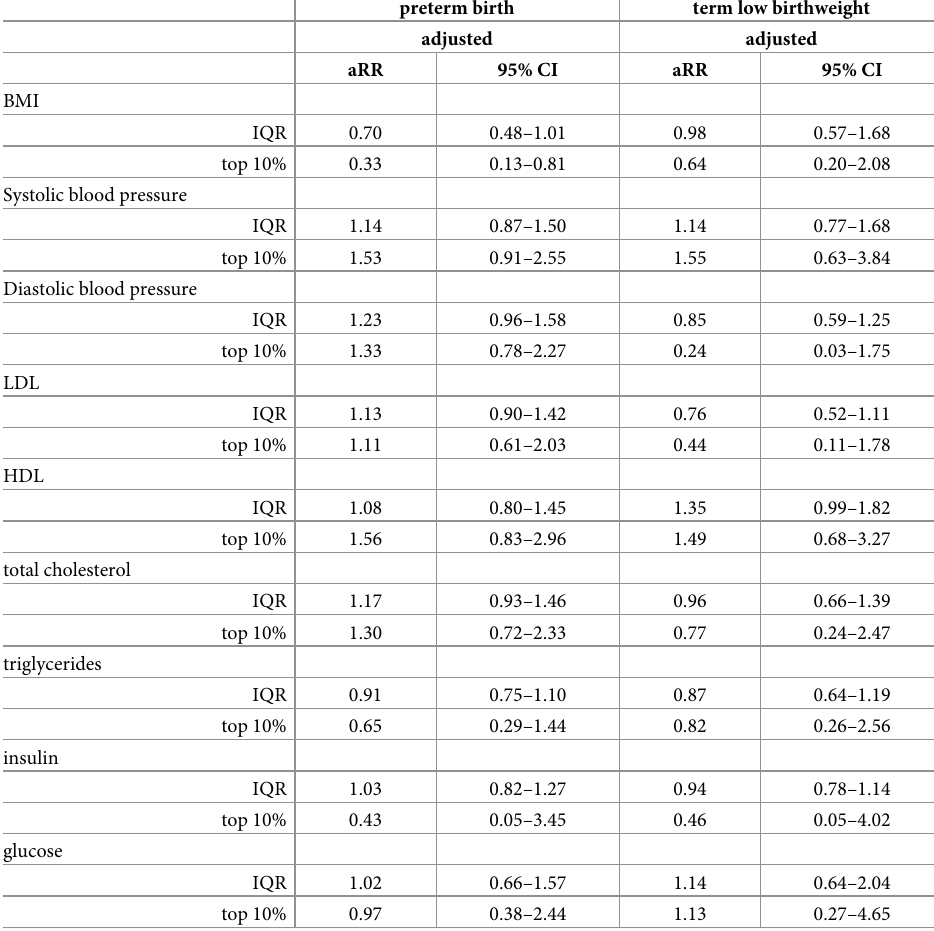
Table 3. Adjusted RR and 95% CI for adverse birth outcomes associated with area under the curve measure of overall burden of childhood cardiovascular risk factors, adjusted for complications of